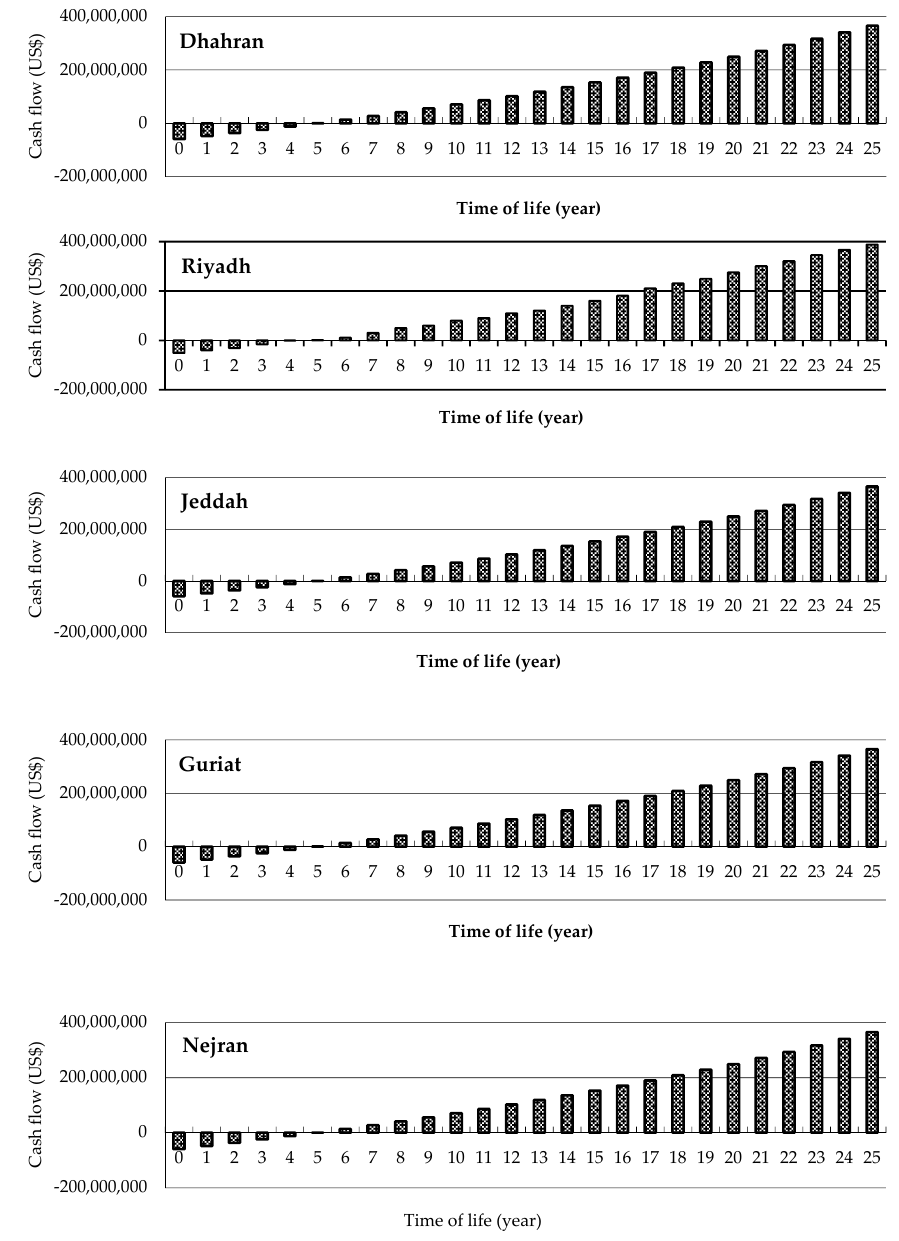
Figure 13. Cumulative cash flow for all sites.